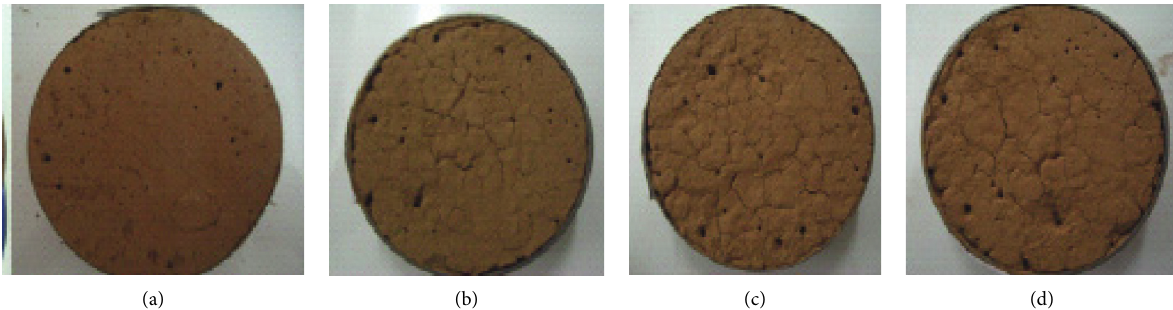
Figure 3: Surface characteristics of Luochuan loess macrostructure during a dry-wet cycle when cycle amplitude ( Δ w ) � 10%. (a). Initial state. (b) One cycle. (c). Three cycles. (d). Five cycles.